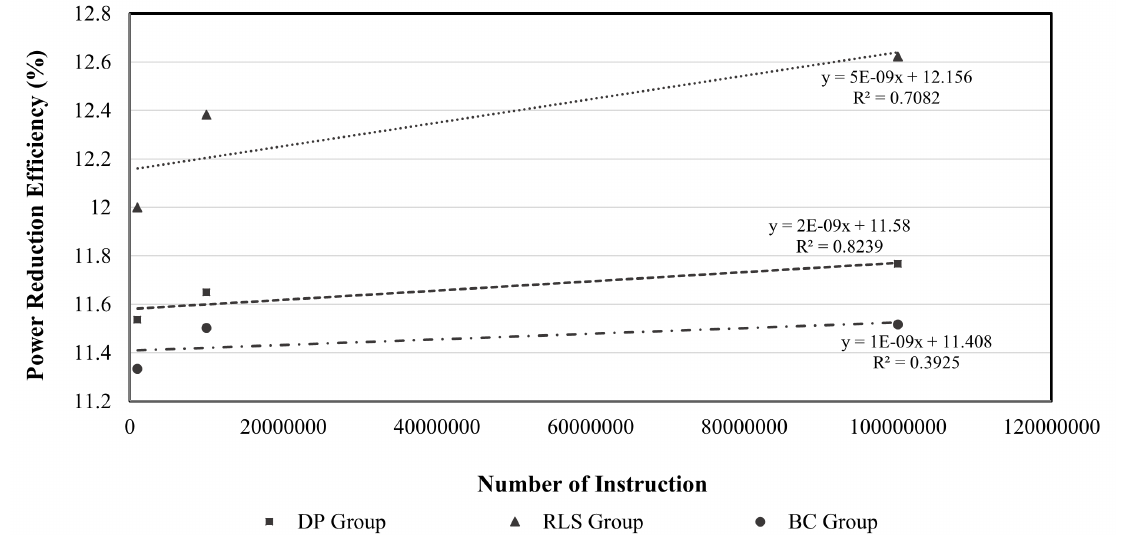
Figure 8. Regression analysis